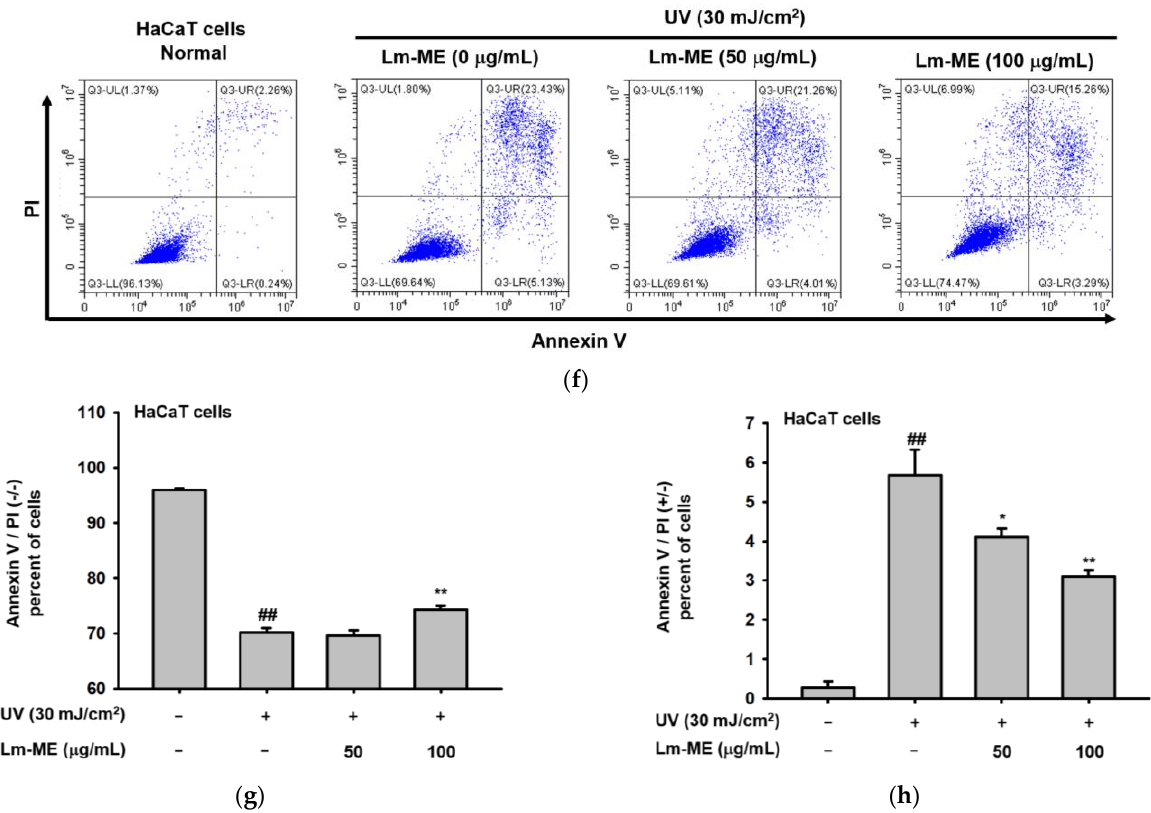
Figure 2. The protective effects of Lm-ME under UVB irradiation. ( a ) HaCaT cells were treated with Lm-ME at 50 and 100 µ g/mL. After 24 h, cell viability was measured using the MTT assay. ( b ) HaCaT cells were stained with DCFDA, which were evaluated with flow cytometry to check ROS production. ( c ) The mRNA expression of MMP-1 and -2 was analyzed using RT-PCR. GAPDH was used as an internal control. ( d ) After UVB induction (30 mJ/cm 2 ), cells were treated with dose-dependently Lm-ME (0–100 µ g/mL) for 24 h. Phosphorylated and total ERK, JNK, and p38 were tested with Western blot. ( e ) HaCaT cells were pretreated with Lm-ME and continuously irradiated with UVB. After 48 h, photos of cells were taken using a digital camera. ( f – h ) HaCaT was stained with annexin V/PI and detected using flow cytometry. The bottom values of c and d indicate the relative intensity measured using ImageJ. ##: p < 0.01 compared to the normal group and *: p < 0.05 and **: p < 0.01 compared to the control group.